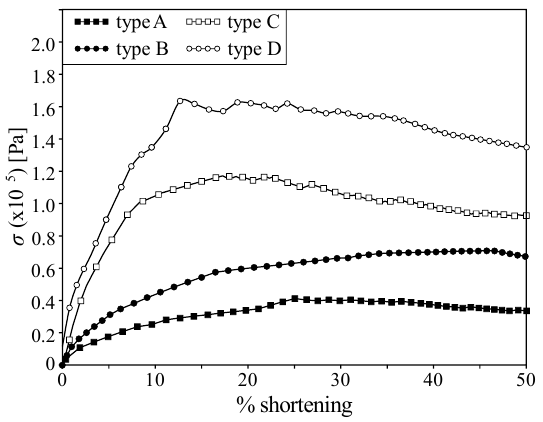
Figure 6. Stress vs. strain curves for the four multilayer experi- ments. Yielding followed by slight strain softening can be clearly identified for models C and D, while experiments A and B record a progressive stress increase that tends towards steady state with increasing